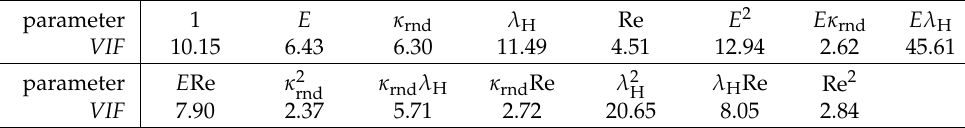
Table 4. Variance inflation factor for the considered regression